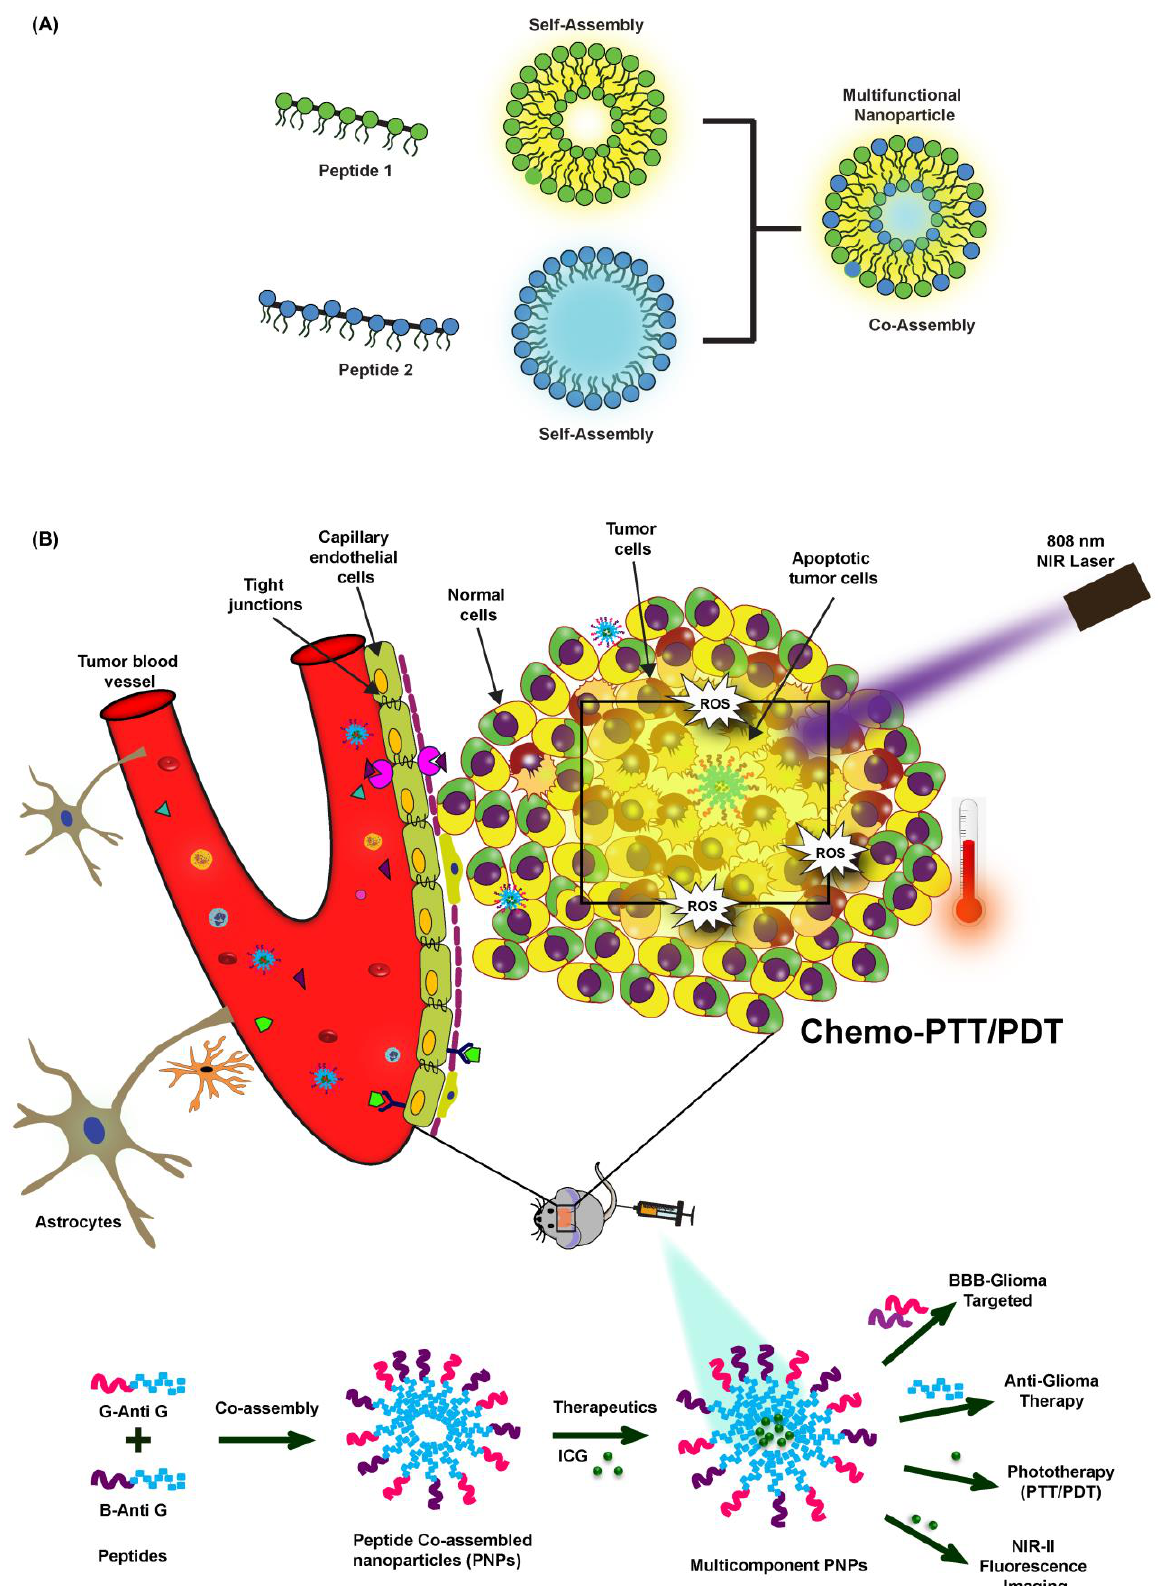
Figure 1. ( A ) Illustration showing peptide-based co-assembled multifunctional nanoparticles. ( B ) Scheme showing the synthesis of blood brain barrier (BBB)-glioma homing and anti-glioma chimeric peptides-based co-assembled nanoparticles (PNPs) loaded with indocyanine green (ICG) for combinatorial fluorescence-based imaging along with enabling the targeted chemo-phototherapy of